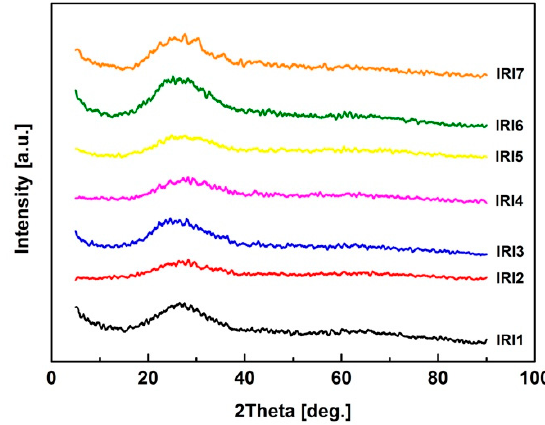
Figure 3. XRD patterns of basalt fiber samples.